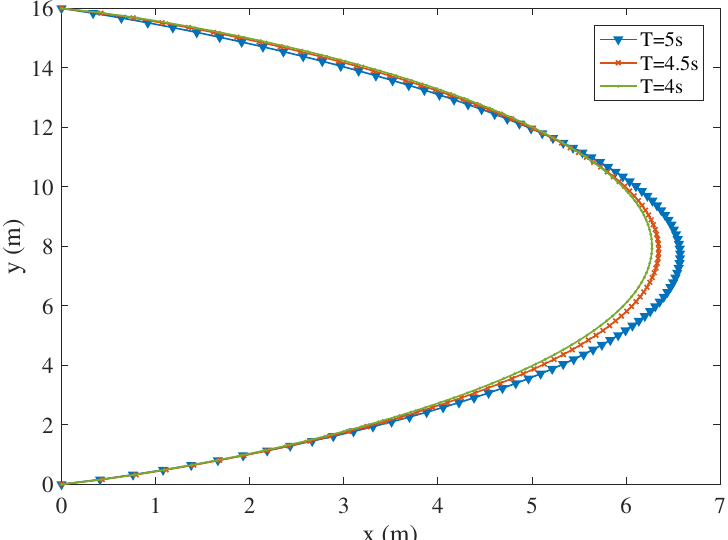
Figure 7. The trajectory of the UAV under different time constraint ( I 1 = 4 × 10 7 bits, I 2 = 5 × 10 7 bits, I 3 = 6 × 10 7 bits, I 4 = 7 × 10 7 bits and I 5 = 8 × 10 7